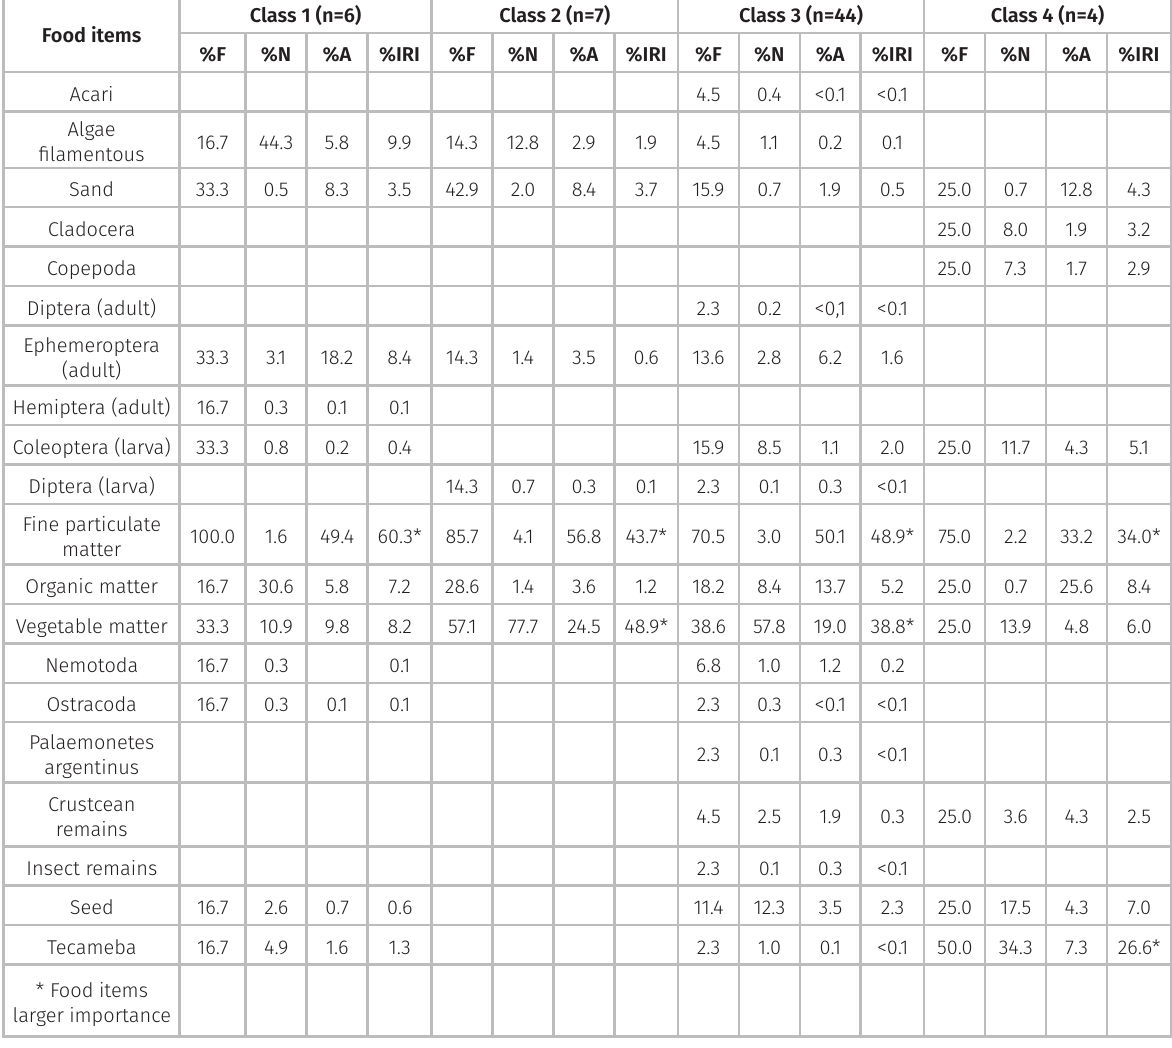
Table V. Frequency of occurrence (%F), numeric frequency (%N), area (%A) and index of relative importance (%IRI) for food items consumed by L. anus in different size classes collected in the Chasqueiro reservoir, southern Brazil. Class 1 Food items